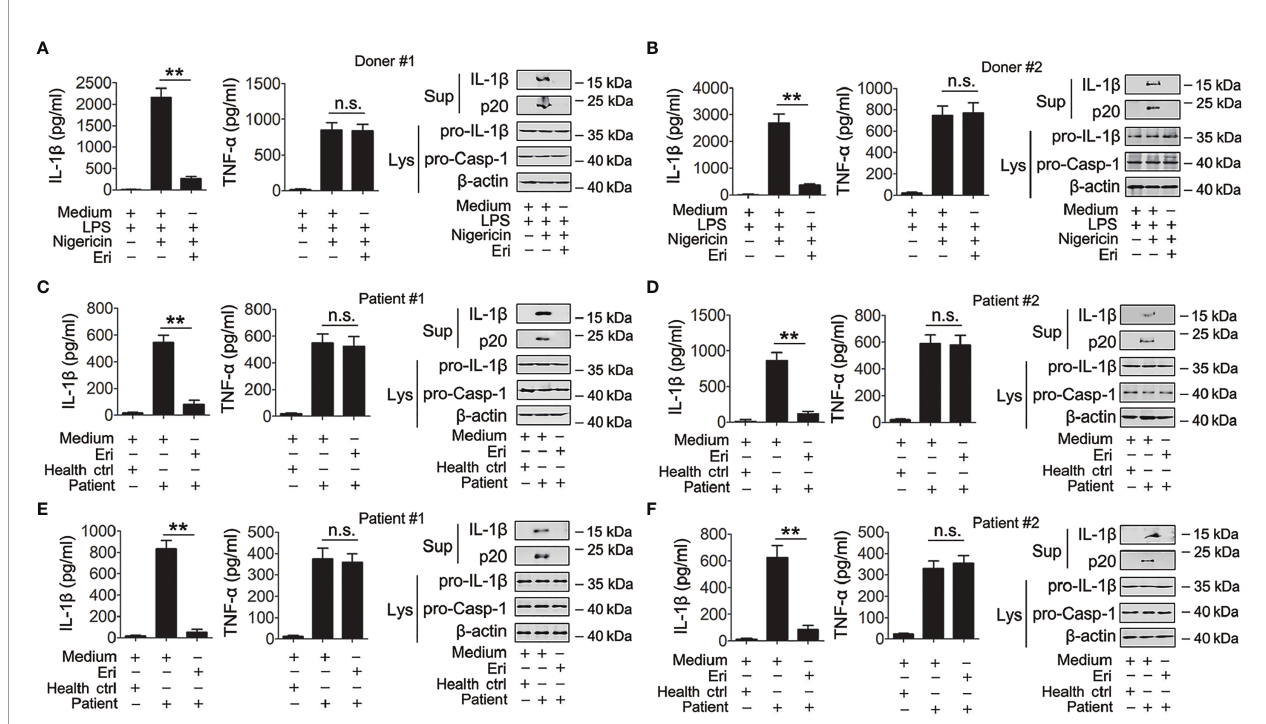
FIGURE 7 | Eri is active for cells from healthy humans, IAV patients or gout patients. (A, B) Freshly isolated PBMCs from donor #1 (A) and donor #2 (B) were treated with or without LPS (1 m g/ml) for 3 h. Then, cells were treated with or without nigericin (2 m M) or Eri (5 nM) for 3 h. IL-1 b (left panel) and TNF- a (middle panel) protein levels were determined by ELISA, or mature IL-1 b and p20 in supernatants or pro-IL-1 b and pro-Casp-1 in lysates were determined by western blot (right panel). (C, D) Freshly isolated PBMCs from health donor, IAV patient #1 (C) or IAV patient #2 (D) were treated with Eri (5 nM) for 6 h. IL-1 b (left panel) and TNF- (middle panel) protein levels were determined by ELISA, or mature IL-1 b and p20 in supernatants or pro-IL-1 b and pro-Casp-1 in lysates were determined by western blot (right panel). (E, F) Experiments were performed as described in (C, D) , except SFCs from gout patients were used. All experiments were repeated at least three times. Bar graphs present means ± SEM, (**P < 0.01). n.s., not signi fi